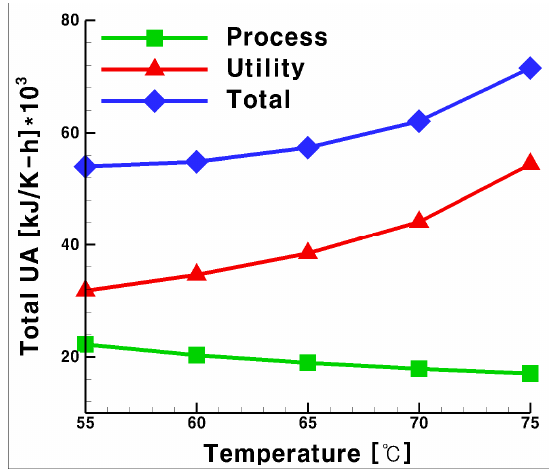
Figure 5. Changes in the total heat transfer area (UA) as a function of temperature in each group in front of the LNG HEX2 when using glycol water as the heat medium.